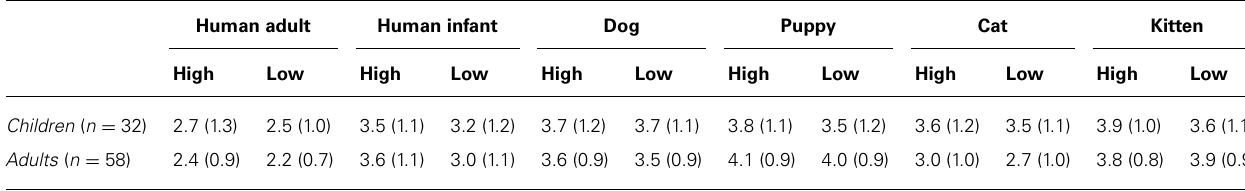
Table 2 |Averaged cuteness ratings for both high infantile and low infantile versions of each image category, given by children and adult participants. Human adult Human infant Dog Puppy Cat Kitten High Low High Low High Low High Low High Low High